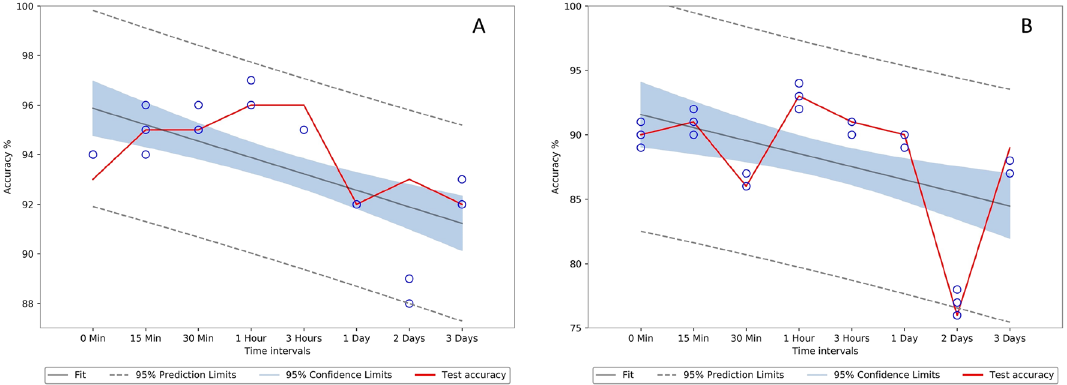
Figure 12. Paper2 confidence interval (CI) plot for beverage classification, ( A ) represents CI for SVM only and ( B ) represents CI for SVM with encoder.